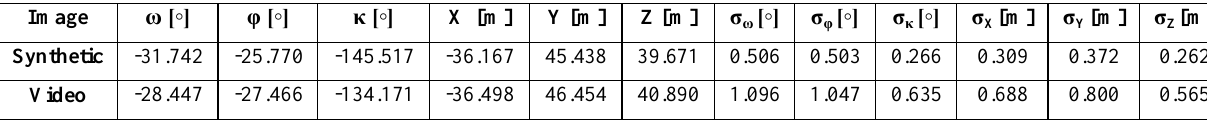
Table 1. Camera EOPs from space resection